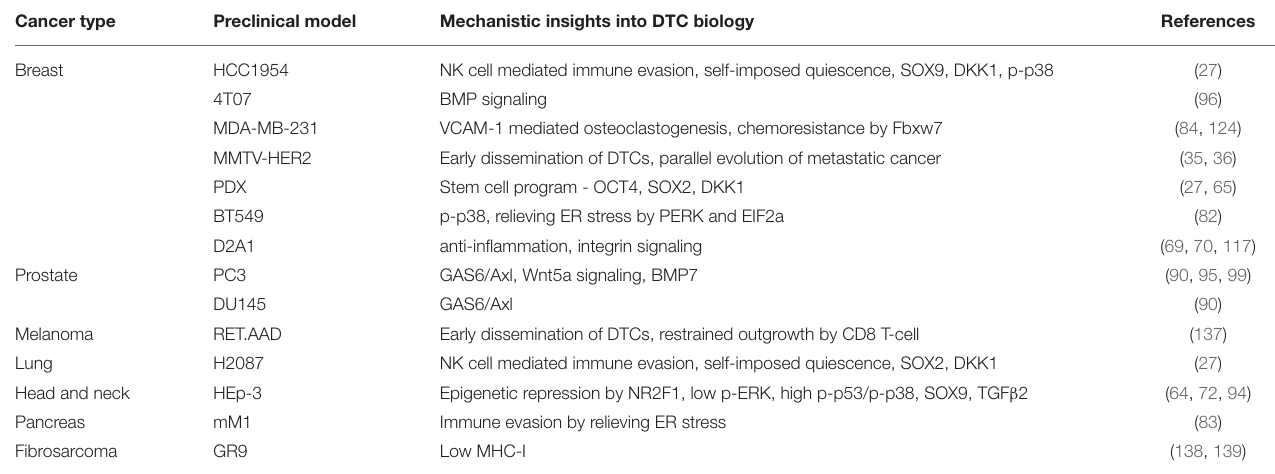
TABLE 2 | Metastatic latency preclinical